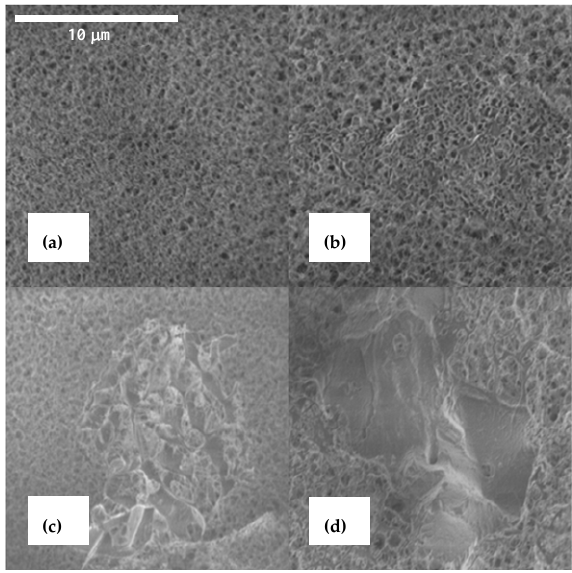
Figure 3. Cryo-SEM images (×5000) of 1-CS ( a ), 2-CS/CM1.5 ( b ), 2-CS/AC1.5 ( c ) and 3-CS/CM1/AC0.5 ( d ). Table 3. BET Specific surface area (S BET ) of the raw and hybrid adsorbents.